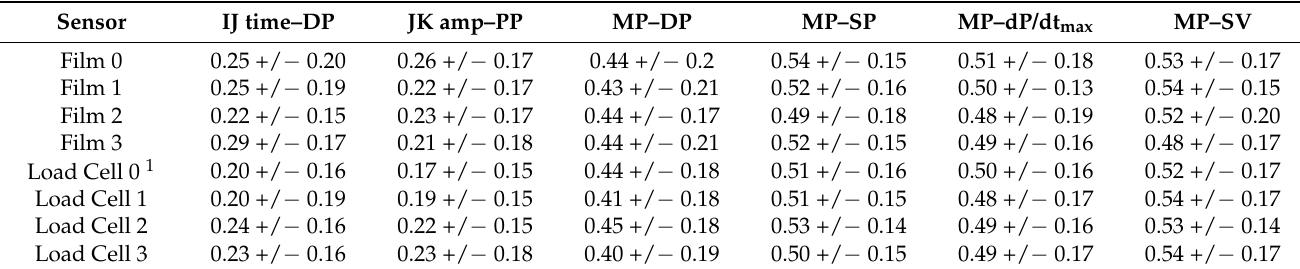
Table 6. Correlation coefficient (mean +/ − stdev.) for each response(s)–predictor pair and each sensor. MP: multiple BCG parameters (IJ time *, JK time *, IJ amp, JK amp). PP: pulse pressure. DP: diastolic pressure. SP: systolic pressure.* Estimates were log-transformed prior to model fitting.